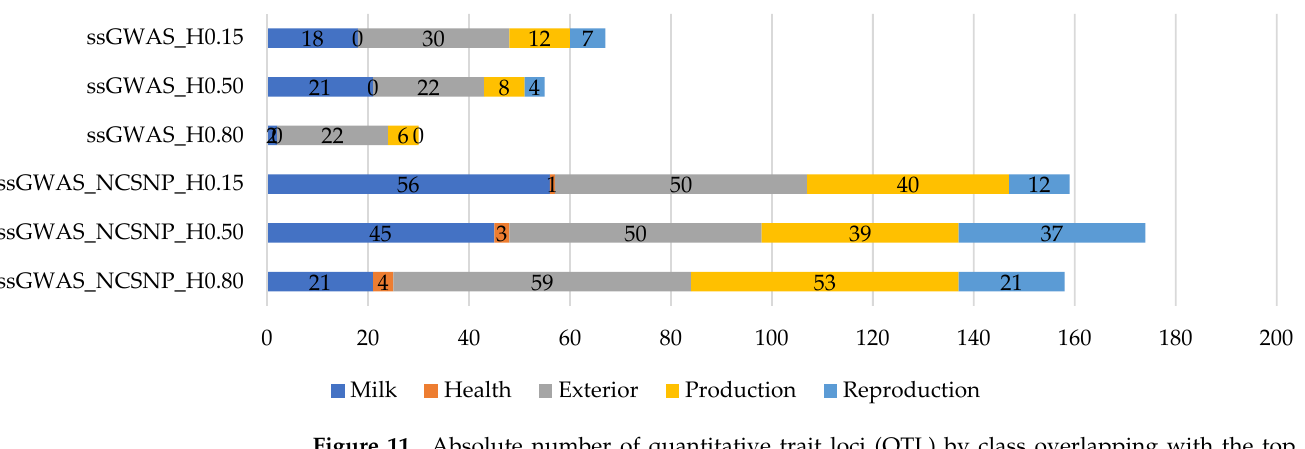
Figure 11. Absolute number of quantitative trait loci (QTL) by class overlapping with the top 0.001% markers for yearling temperament in American Angus cattle using the single-step GWAS fitting only haplotypes or non-clustered SNPs and haplotypes. ssGWAS_H0.15, ssGWAS_H0.50, and ssGWAS_H0.80: ssGWAS using only haplotypes from blocks with linkage disequilibrium (LD) thresholds of 0.15, 0.50, and 0.80, respectively; ssGWAS_NCSNP_H0.15, ssGWAS_NCSNP_H0.50, and ssGWAS_NCSNP_H0.80: ssGWAS using non-clustered SNPs and haplotypes from blocks with LD thresholds of 0.15, 0.50, and 0.80, respectively.